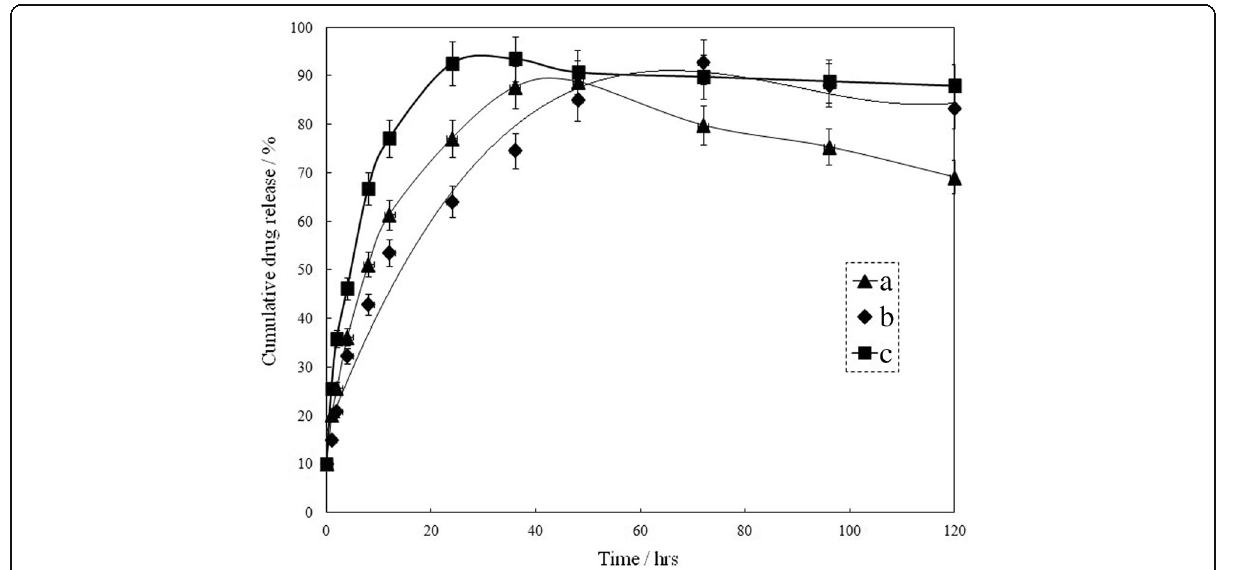
Fig. 6 Release profiles of cis -DIDP from the cis -DIDP@PCL fibers in a deionized water, b normal saline, and c PBS, at room temperature. Each data point represents the average of three